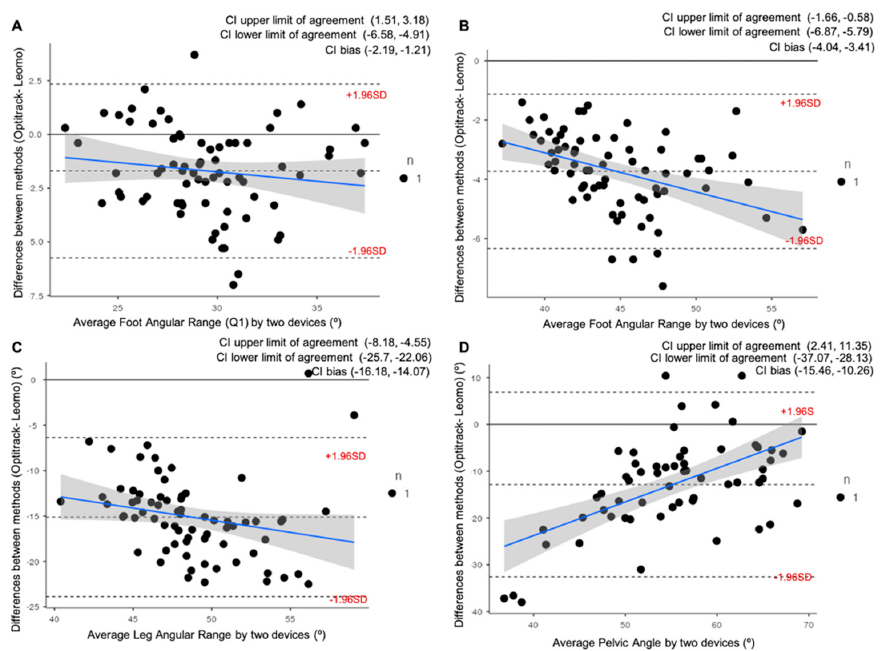
Figure 4. Bland–Altman plots representing comparisons between the Optitrack system and the Leomo system for four of the variables analyzed at VT2: ( A ) Average Foot Angular Range at first quartile of the pedaling cycle (Q1); ( B ) Average Foot Angular Range; ( C ) Average Leg Angular Range; ( D ) Average Pelvic Angle. The mean line represents the mean difference between the devices, with the upper and lower dashed lines representing the 95% limits of agreement (LOAs). 95% confidence intervals (CI) of the upper LOAs, lower LOAs, and bias are shown in the legend of each figure.